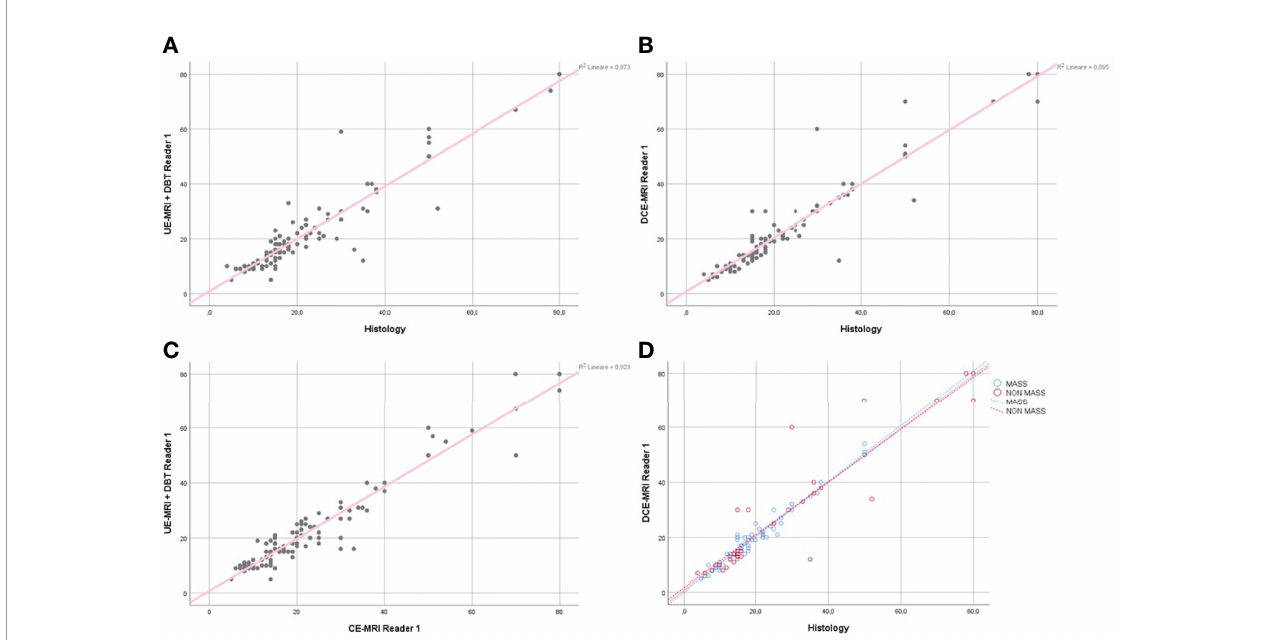
FIGURE 4 | Reader 1 lesions size assessment. Regression analysis for the lesion size, comparing UE-MRI+DBT vs Histology (A) , DCE-MRI vs Histology (B) and UE-MRI+DBT vs DCE-MRI (C) . Section (D) shows the regression analysis performed dividing the lesions into the mass and non-mass groups, comparing DCE-MRI vs Histology.